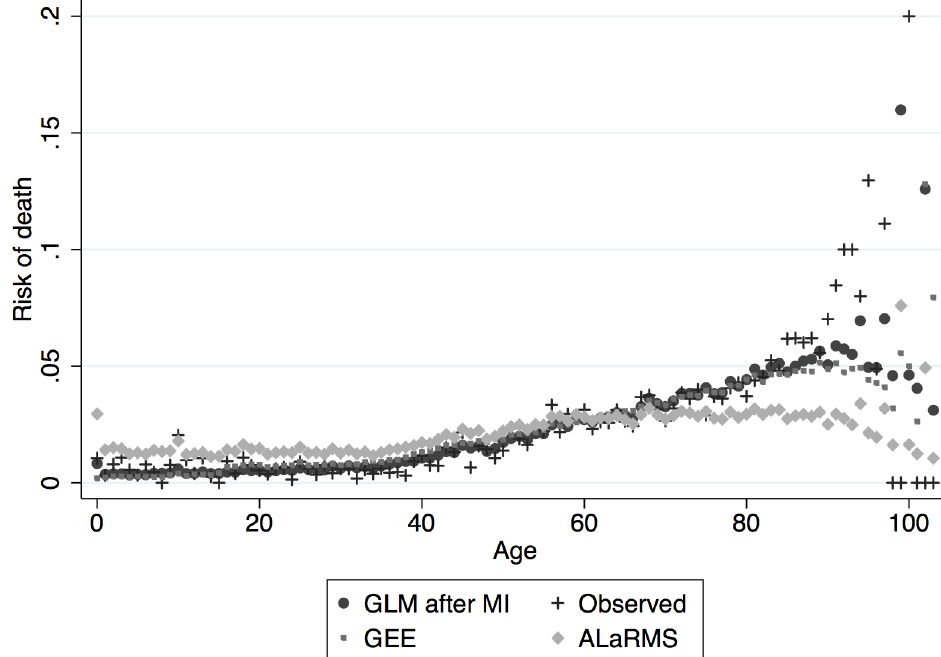
Fig 4. Model calibration according to ‘ Age ’ . Observed vs. Expected risk of death for GEE, GLM, and ALaRMS.